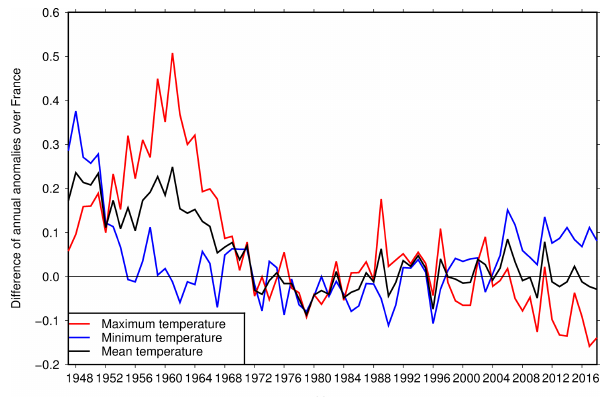
Figure 2. Differences between annual anomalies from the national thermic index and annual anomalies from ANASTASIA production over 1947–2018 period for minimum temperature (in blue), maxi- mum temperature (in red) and mean temperature (in black).